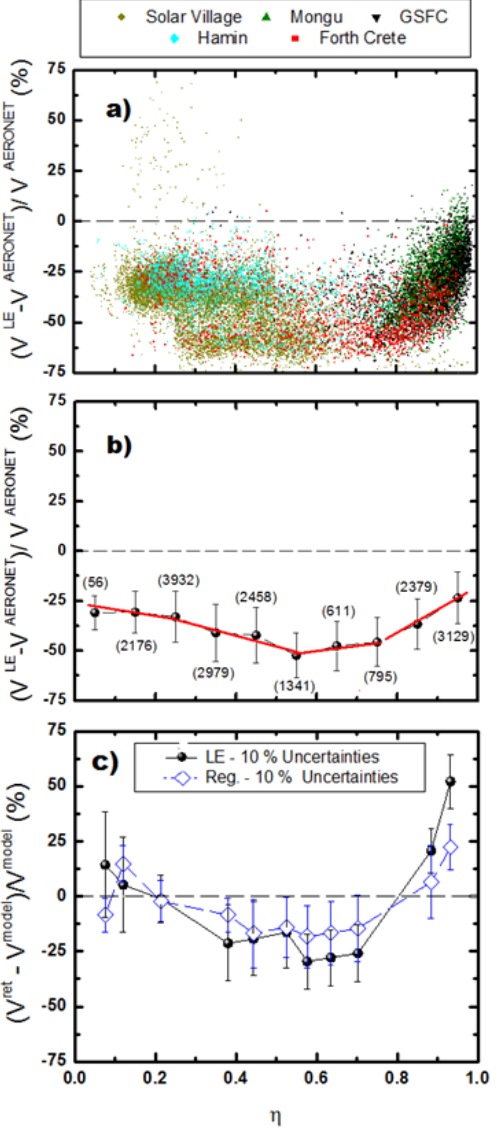
Figure 11. Relative differences of the columnar volume aerosol content obtained by linear estimation ( V LE ) and those obtained by AERONET ( V AERONET ) for (a) all the data points from the se- lected AERONET reference sites and (b) average values. The red lines represent the different linear fits performed. Number in paren- thesis indicates the number of intercomparisons for the above/below point. Also, (c) relative differences between model ( V model ) and re- trieved ( V ret ) data for fixed particle size distributions. Results are based on simulated data. Linear estimation and regularization tech- niques are included, and 10% noise is